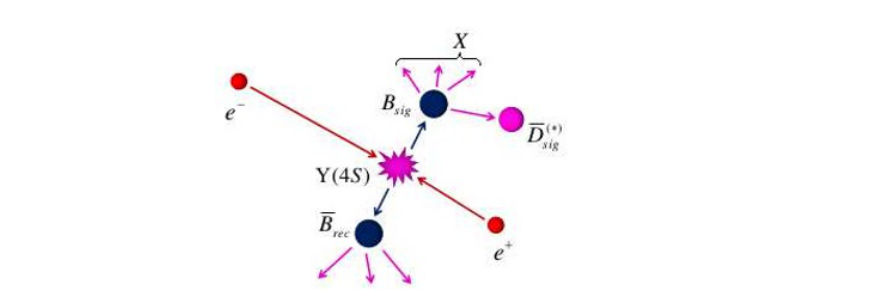
Figure 2. Diagram of the studied